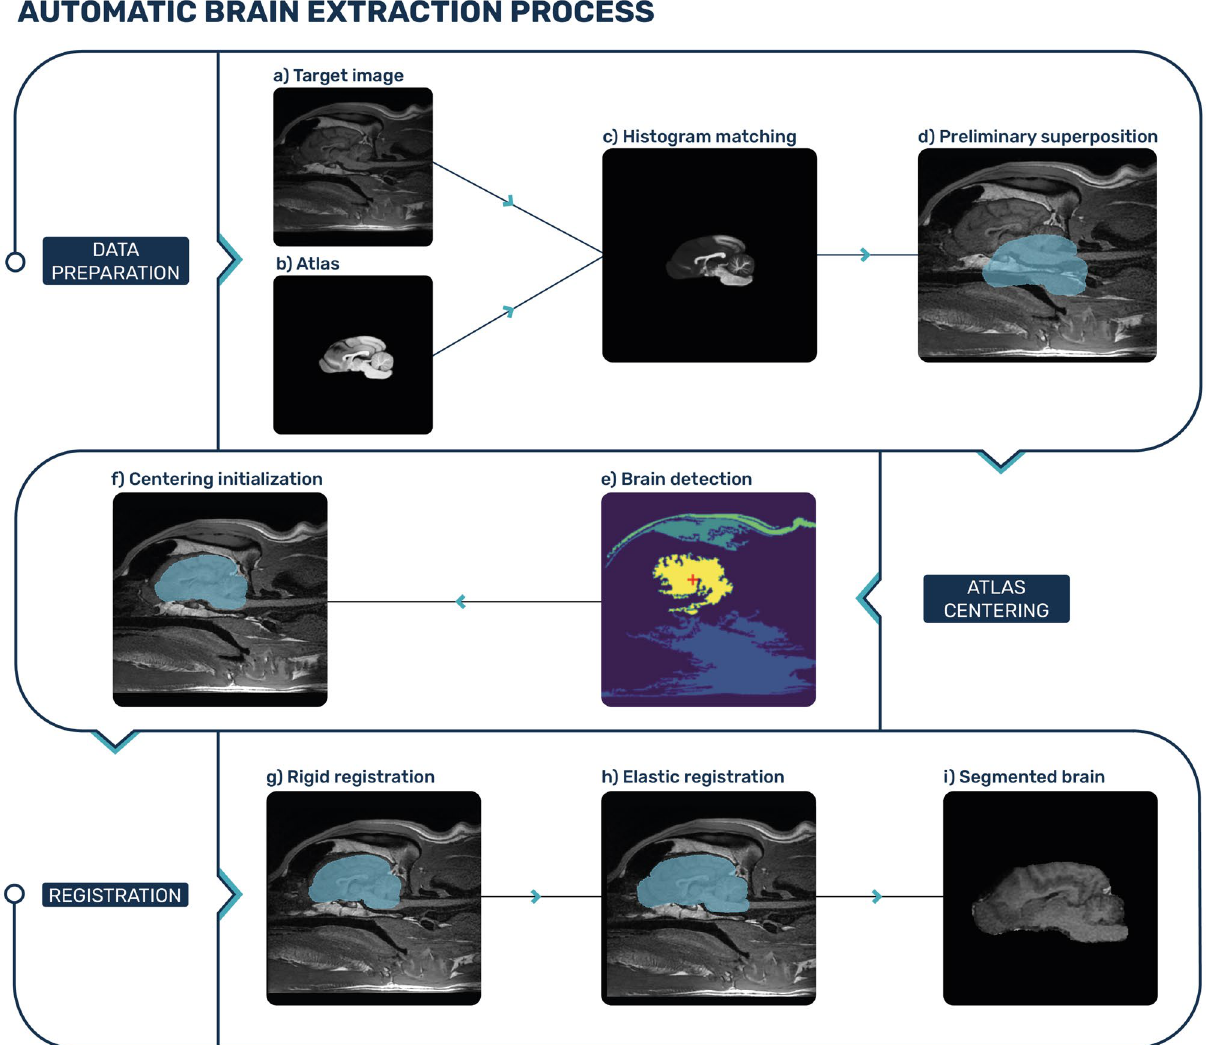
Figure 1. Scheme of the brain extraction algorithm workflow, example on a canine subject. ( a ) Target image of a MRI brain acquisition, in which we want to extract the brain. ( b ) Atlas chosen for the segmentation process. In this paper we used the atlas from Johnson et al. 20 . ( c ) Histogram matching between the atlas and the target image’s grayscale. ( d ) Preliminary superposition of the atlas over the target image. ( e ) Detection of the brain region using Felzenszwalb segmentation method: the target image is segmented into regions to locate the brain’s center. ( f ) Translation of the atlas center towards the target image’s brain center, to align both brains’ centers and ease the rigid registration step. ( g ) Rigid registration of the atlas for optimal atlas-to-target superposition. ( h ) Elastic registration of the atlas to fully adapt the atlas to the target’s brain and overcome any anatomical variability. ( i ) Completed brain extraction after the registration of the acquired MRI volume to locate the brain. The scale of the expected regions to segment can be set as hyper- parameter, which makes this graph-based segmentation algorithm ideal for the detection of objects of a roughly known size, such as the brain. The reference scale chosen to define the hyperparameters was the resampled atlas surface ( S atlas ), calculated as the number of non-background pixels in the central 2D slice of the resampled atlas. The hyperparameters thus scale with the resolution of the target image, and the segmentation outcome does not depend on it. The scale of observation used is k = 200 S atlas . A smoothing Gaussian filter with σ = 0.5 is applied to make Felzenswalb algorithm less dependent on details and noise. The region corresponding to the brain is selected as the one whose centroid is closest to a reference point, assigned to each anatomical plane (sagittal, dorsal and transverse), and representing the average brain’s position. The atlas is finally translated to match the position of the detected brain in the target image (Fig. 1f). Rigid registration. To precisely superpose the atlas (used as moving image) over the brain of the subject (used as fixed image), a rigid transformation consisting of a 3D translation and a 3D rotation was performed (Fig. 1g). A gradient descent was used as optimizer for the registration (step size = 1, number of iterations = 50, conver- gence minimum value = 10 − 6 within a convergence window of size 10), and a B-spline interpolator to interpolate